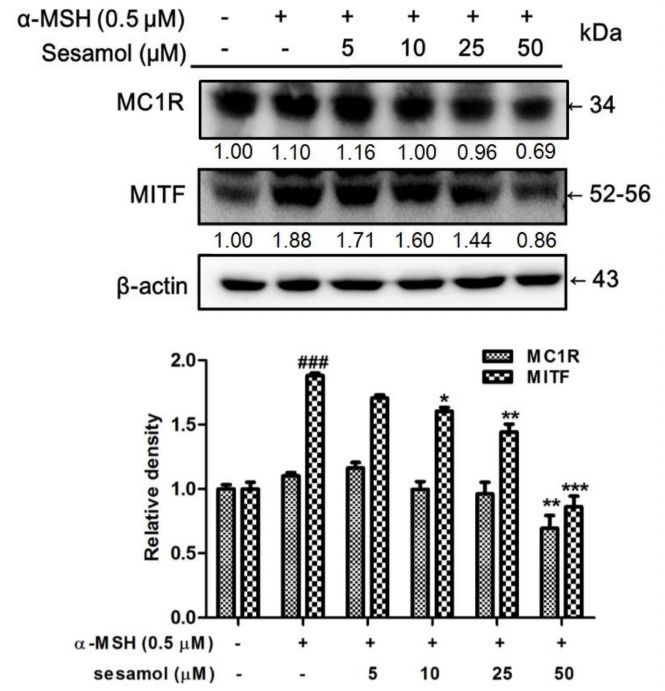
Figure 4. Effect of sesamol on α -MSH-induced protein expression of MC1R and MITF in B16F10 cells. Each value is presented as the mean ± SD. Significant difference versus control: ### p < 0.001; Significant difference versus α -MSH-treated group: * p < 0.05, ** p < 0.01, *** p < 0.001.